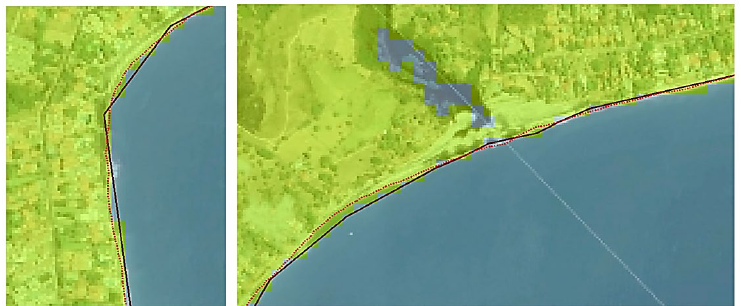
Figure 16. Misclassified pixels. Dashed line = shoreline digitized manually from Google earth pro. Solid line = shoreline automatically extracted from Landsat image.